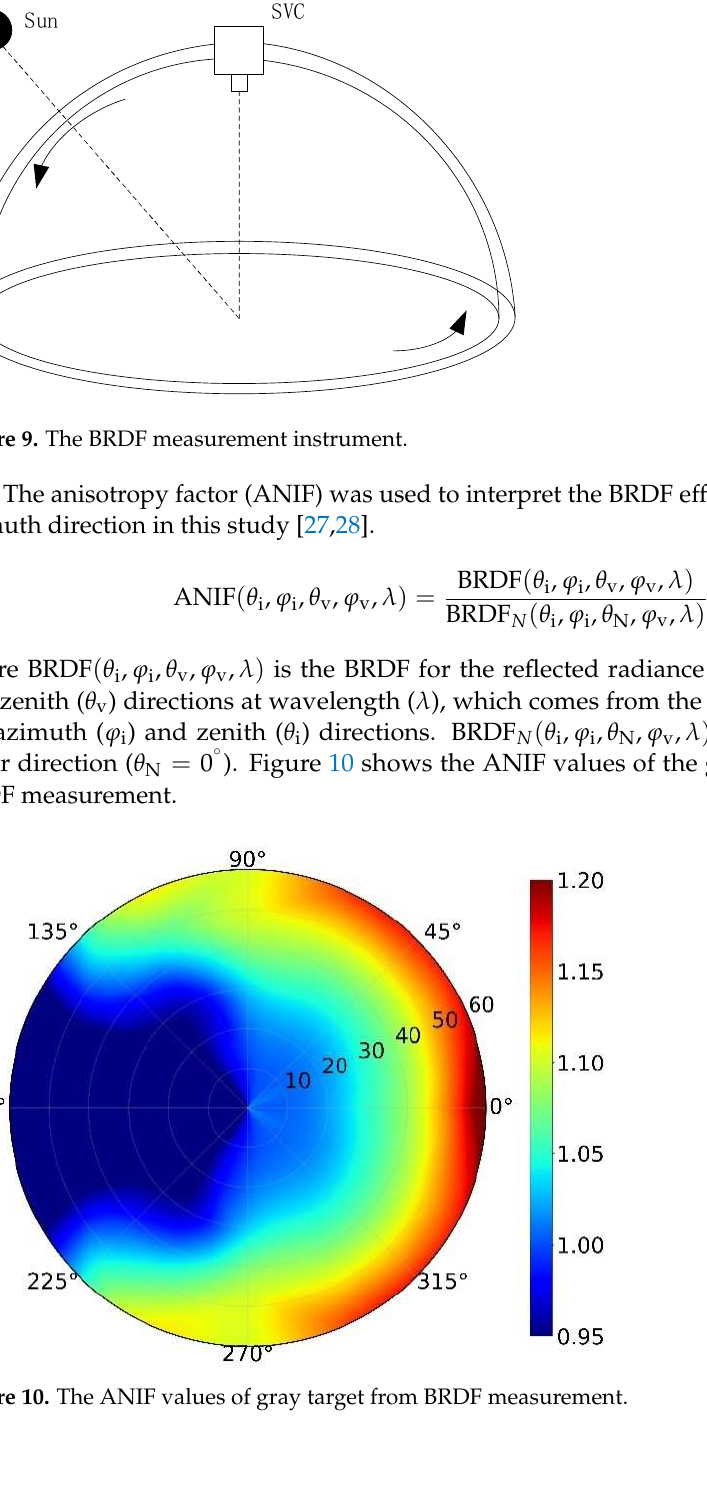
Figure 8. Spectral reflectance measurement data of gray-scale permanent targets. In this study, a multi-angle bidirectional reflectance distribution function (BRDF) measurement instrument was used to quantify the bidirectional reflectance effect of the gray-scale permanent targets, as shown in Figure 9. The BRDF characteristics of the gray-scale permanent targets were measured according to the angle of incidence and reflection, using the SVC spectroradiometer with the multi-angle instrument [26]. The measured BRDF values of the targets were interpolated at 1 nm intervals in the 400–1000 nm wavelength range.